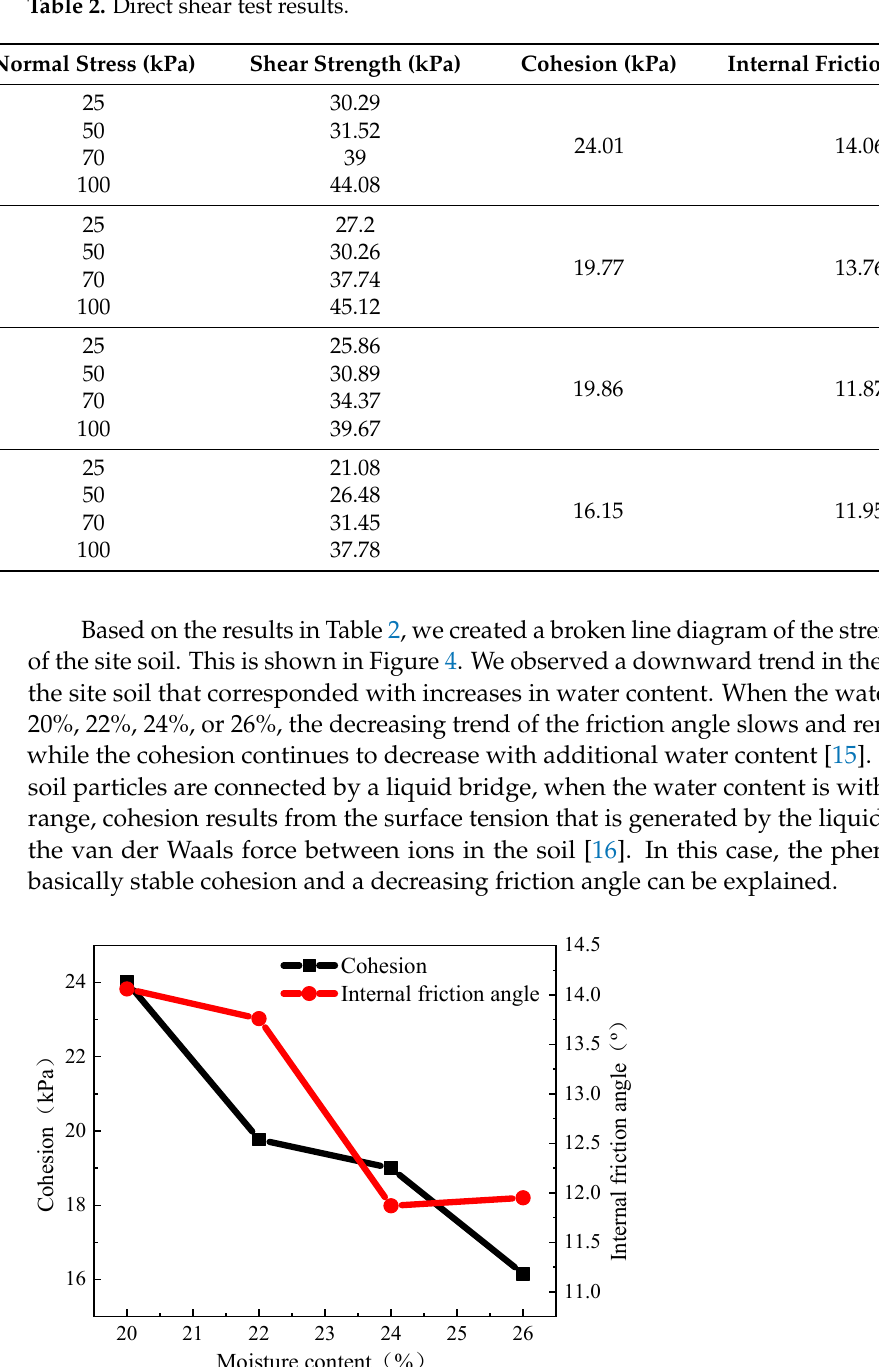
Table 2. Direct shear test results.